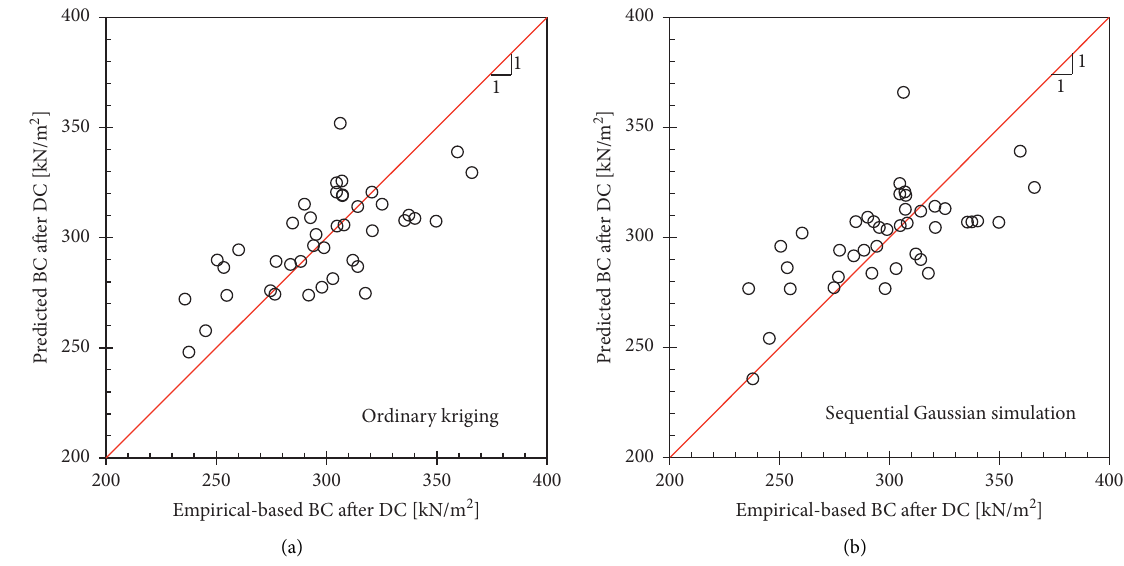
Figure 5: Leave one out cross-validation (LOOCV) results of geostatistical models. The predicted bearing capacity BC after dynamic compaction (DC) is obtained using: (a) Ordinary kriging (OK) and (b) Sequential Gaussian simulation (SGS). Empirical-based bearing capacity after DC is computed using equation